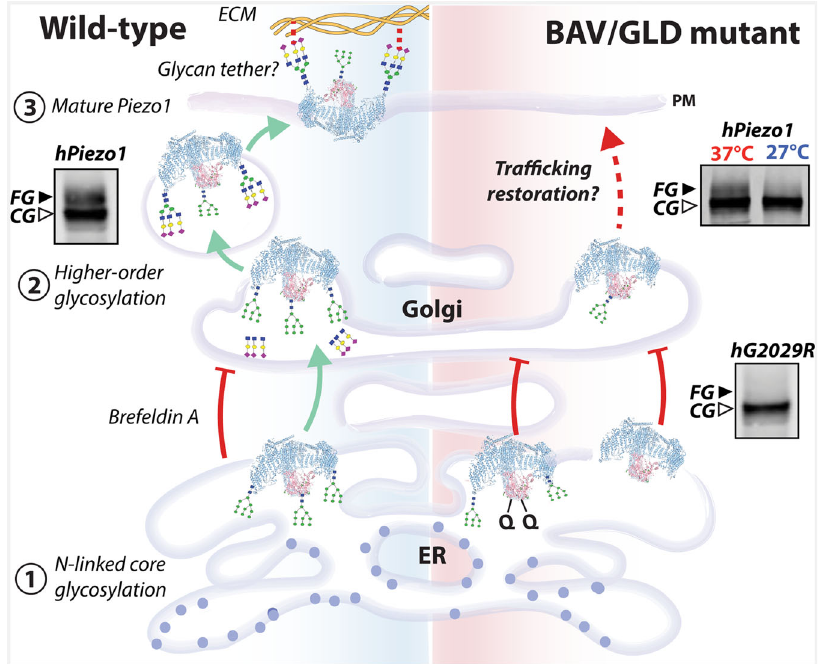
Fig. 9 Summary of Piezo1 biosynthetic pathway. Core-glycans added in the cap (N2294/N2331) while folding in the ER are critical for the larger N-glycans in the propeller (primarily at N885) which are processed in the Golgi. Aberration of glycosylation re fl ects impaired traf fi cking, and perhaps the larger glycans may act as molecular tethers linking to the ECM as suggested for ENaC 70 . Summary adapted from Kanner et al. 60